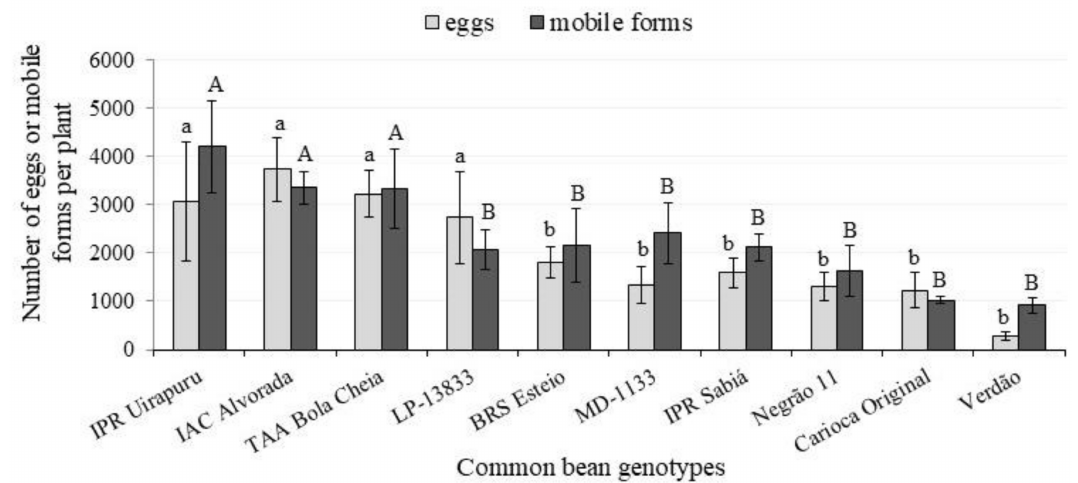
Figure 3. Number of eggs (clear column) and mobile forms (larvae + adults) (dark column) of Polyphagotarsonemus latus per plant 15 days after infestation of common bean genotypes. Bars over the columns indicate standard errors. Columns with the same letter, lower case (a, b) for “eggs” and capital letters (A, B) for “mobile forms”, do not differ by Scott–Knott test ( α =